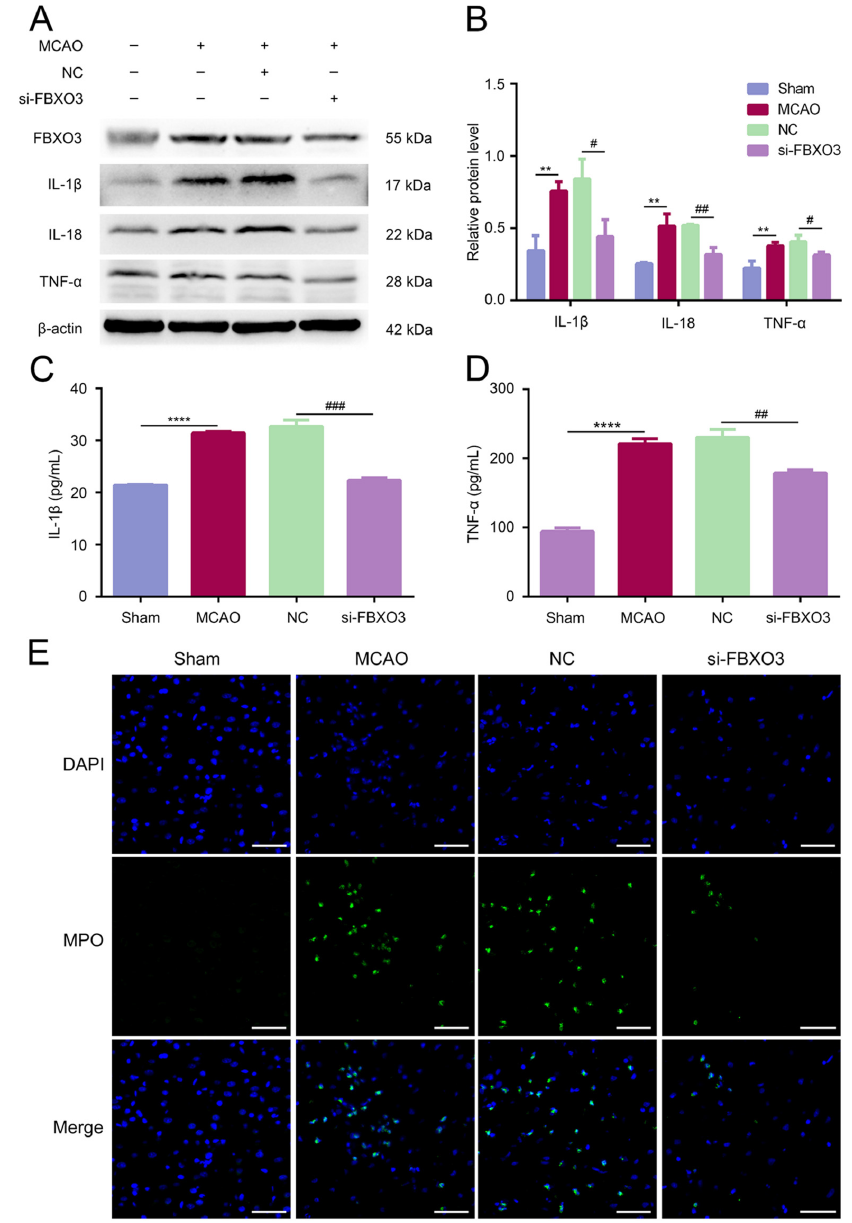
Figure 4. Treatment of si ‐ FBXO3 inhibited inflammatory response induced by ischemia/reperfusion (I/R) injury in vivo. ( A , B ) WB analysis of inflammatory cytokines including IL ‐ 1 β , IL ‐ 18, and TNF α in the peri ‐ infarcted cortex of MCAO/R rats with or without siRNA treatment and in sham rats.